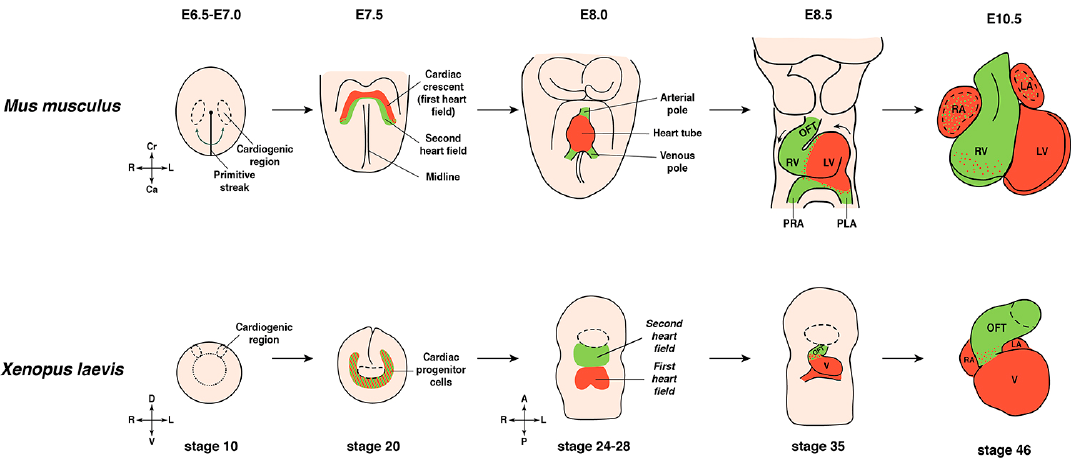
Figure 1. Early cardiogenesis in mouse (upper panel) and Xenopus (lower panel). During gastrulation myocardial progenitor cells arise from the mesoderm and migrate to the ventral midline to the anterior part of the embryo. The progenitor cells form the cardiac crescent (first heart field), which already includes differentiated cardiomyocytes. The primary heart tube is formed at the ventral midline, starts to beat and undergoes looping and further morphological remodeling. Subsequently, the different cardiac chambers are formed. Cr-Ca/D-V/A-P and R-L axes are indicated. A: anterior; Ca, caudal; Cr: cranial; D: dorsal; L: left; LA: left atrium; LV: left ventricle; OFT: outflow tract; PLA: primitive left atrium; P: posterior; PRA: primitive right atrium; R: right; RA: right atrium; RV: right ventricle; V: ventral.